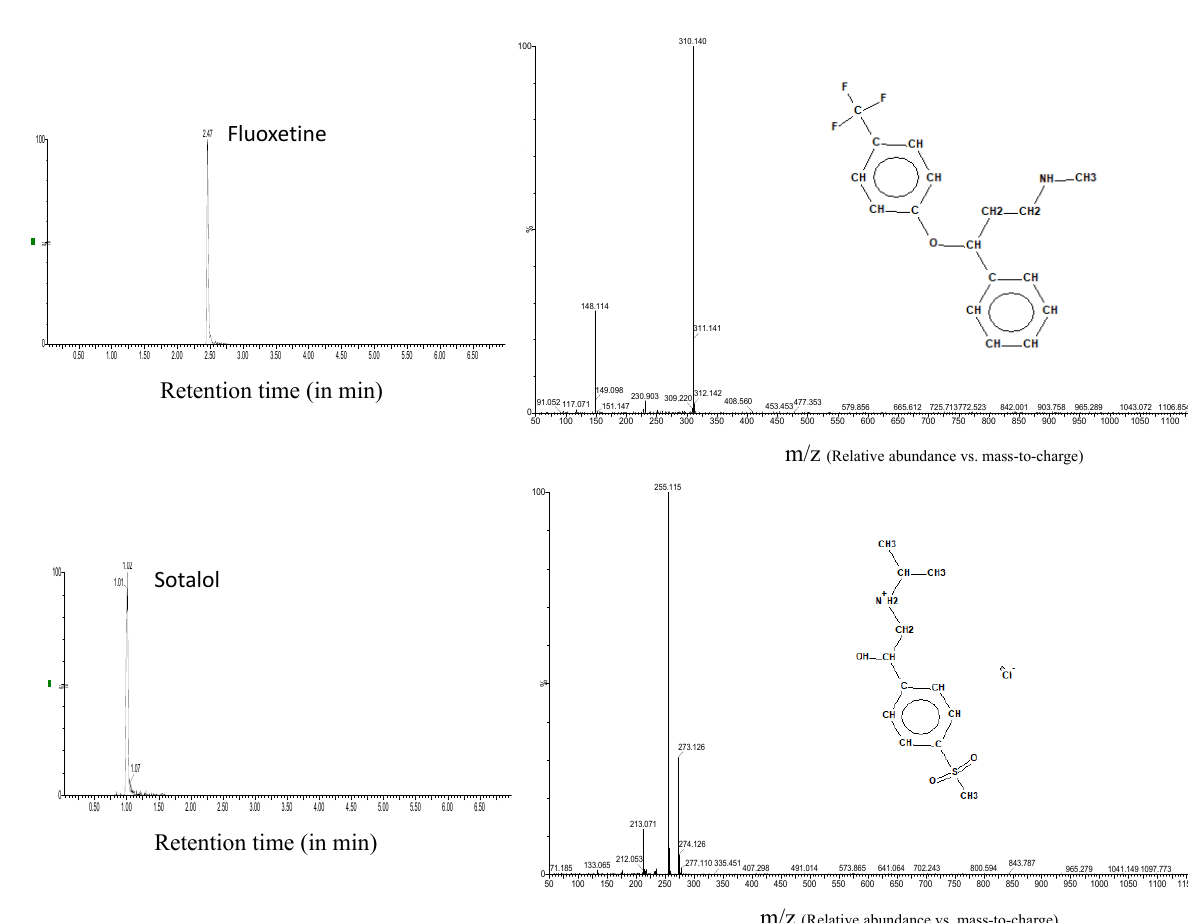
Figure A1. Chromatograms and mass spectra of the four molecules under